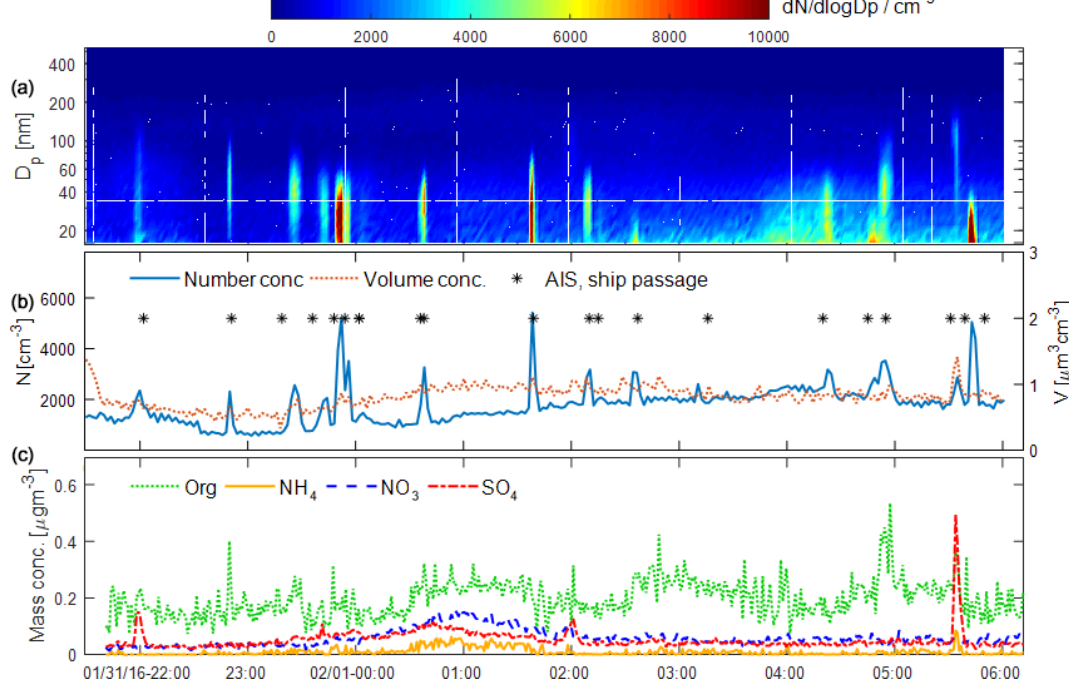
Figure 2. Aerosol particle properties measured with an SMPS and an SP-AMS versus time (31 January–1 February 2016), from measure- ments at the coastline in southern Sweden during an episode with westerly winds blowing from the Øresund Strait to the coastal station Falsterbo. The concentrations are those of the total aerosol; i.e. background concentrations are not subtracted. (a) Two-dimensional colour plot of total particle number size distribution from the SMPS. (b) The total number and volume concentrations from the SMPS and incidents of ship plume passages determined with AIS and meteorological data. (c) Concentration of the chemical constituents from the SP-AMS; total organics (Org), ammonium (NH 4 ), nitrate (NO 3 ), and sulfate (SO 4 ). The wind direction (269 ± 14 ◦ ) and wind speed (8 . 7 ± 1 . 1ms − 1 ) can be considered stable during this